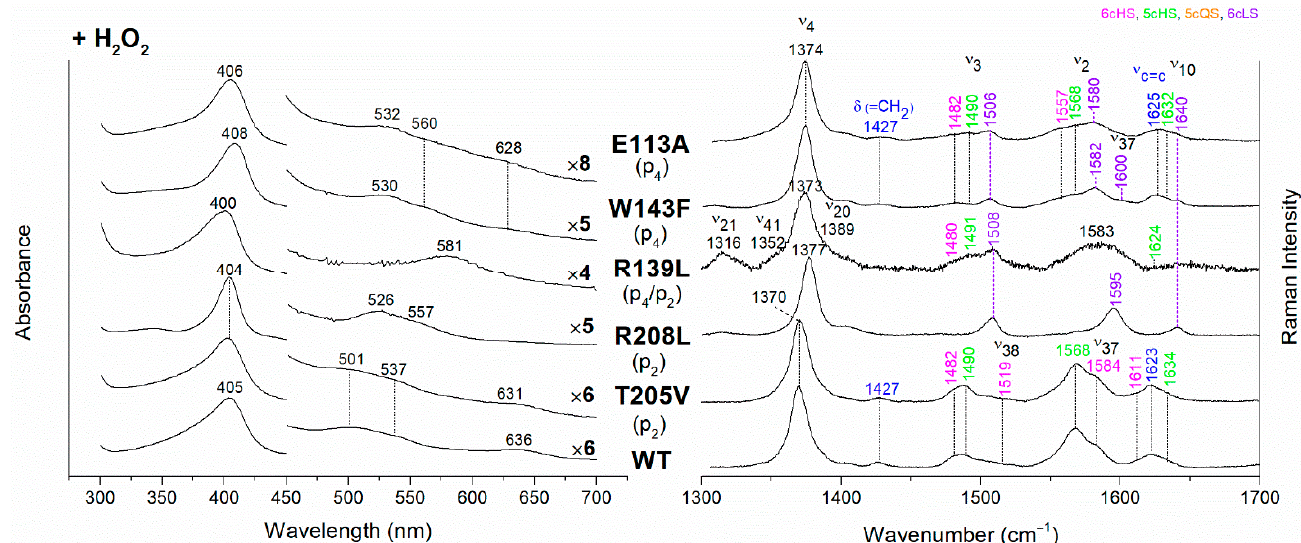
Figure 4. ( Left ) UV-vis electronic absorption spectra and ( Right ) RR spectra in the high wavenumber region of coproheme complexes upon H 2 O 2 titration of Cd ChdC WT and variants. In brackets, the propionate, whose corresponding H-bond is removed by mutation, is reported. The RR core-size marker band wavenumbers are reported in pink, green, orange and violet for the 6cHS, 5cHS, 5cQS and 6cLS species, respectively, while in blue are indicated the vinyl vibrations ( ν C=C stretching modes and δ (=CH 2 ) bending modes), and in black, at the side of the UV-vis spectra, are indicated the expansion factors applied in the 450–700 nm spectral range for better data visualization.